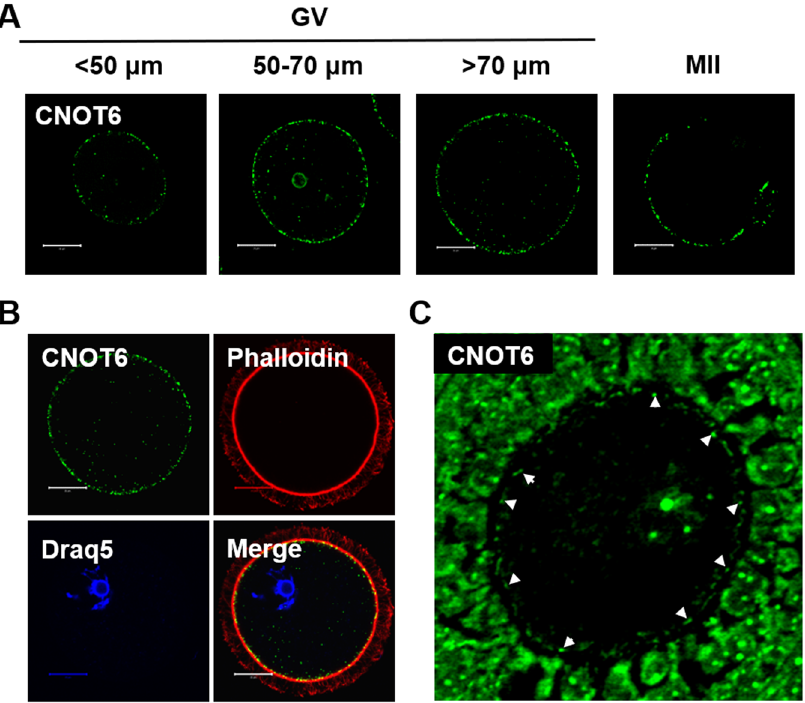
Figure 3. Localization of CNOT6 in growing and fully grown oocytes. ( A ) Whole-cell immunofluorescence of growing, fully grown and mature (MII) oocytes. Foci of CNOT6 staining are detectable at the periphery of the oocyte. ( B ) Whole-cell immunofluorescence of fully grown oocytes co-stained using anti-CNOT6 (green) and phalloidin (red) to reveal the actin-rich cortex. CNOT6 foci are predominantly located within the cortex of the oocytes. The nucleus is labelled using DRAQ5 (blue). ( C ) Immunohistochemistry of sections of paraffin- embedded ovaries confirms the cortical distribution of CNOT6 foci (arrowheads) in oocytes. Bar = 20 µ m.